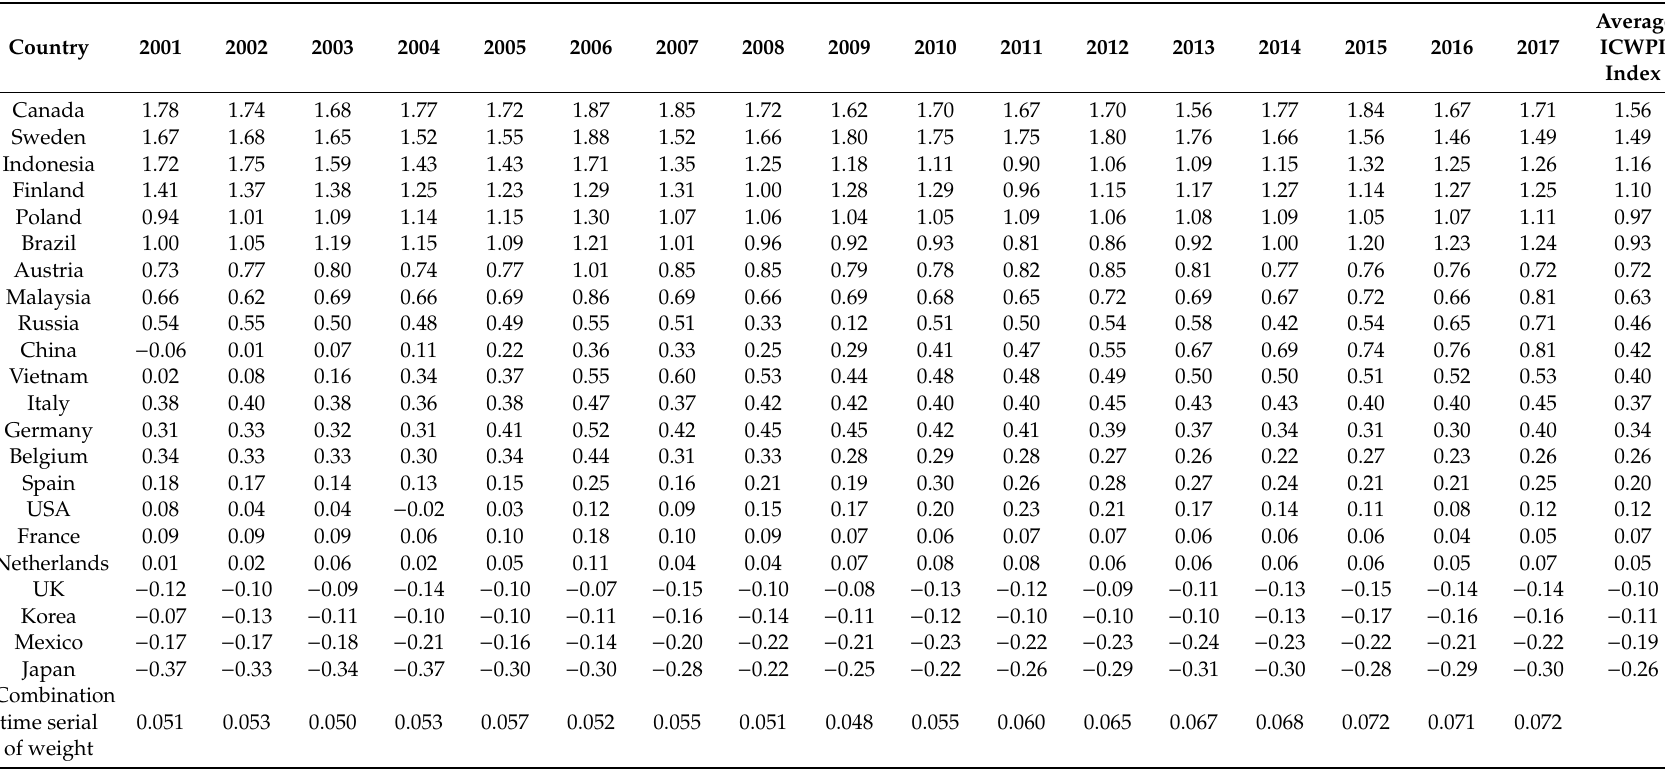
Table 3. Comprehensive international competitiveness index (V i ) of the 22 selected countries. ICWPI: international competitiveness of the wood processing industry.